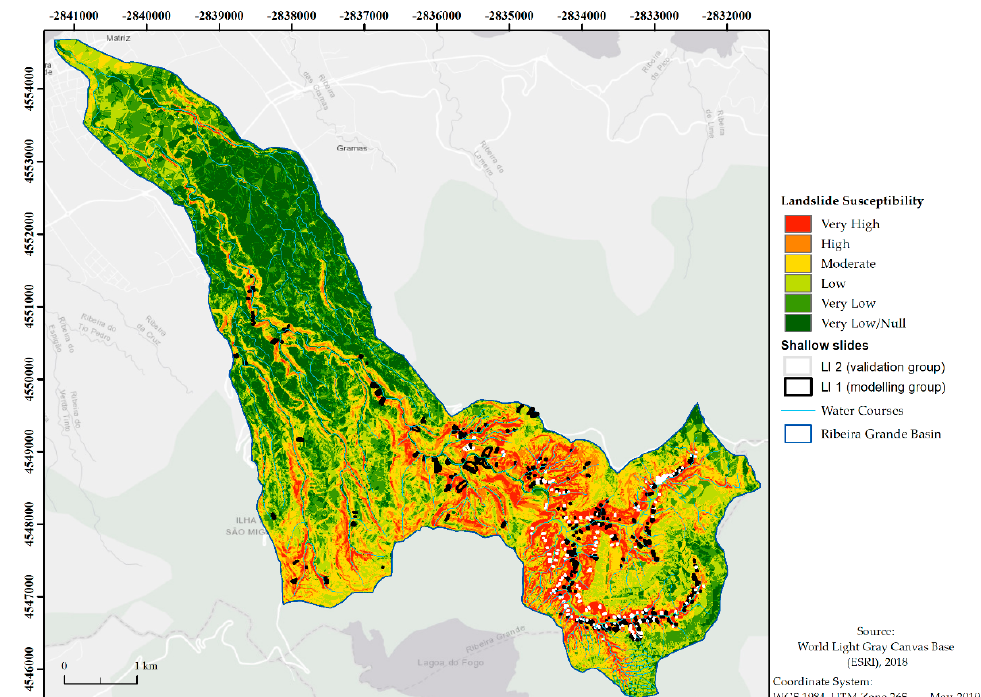
Figure 12. Model C1: Susceptibility to landslides triggered by rainfall (LI 1) in the entire basin (using IV scores of Model B1).